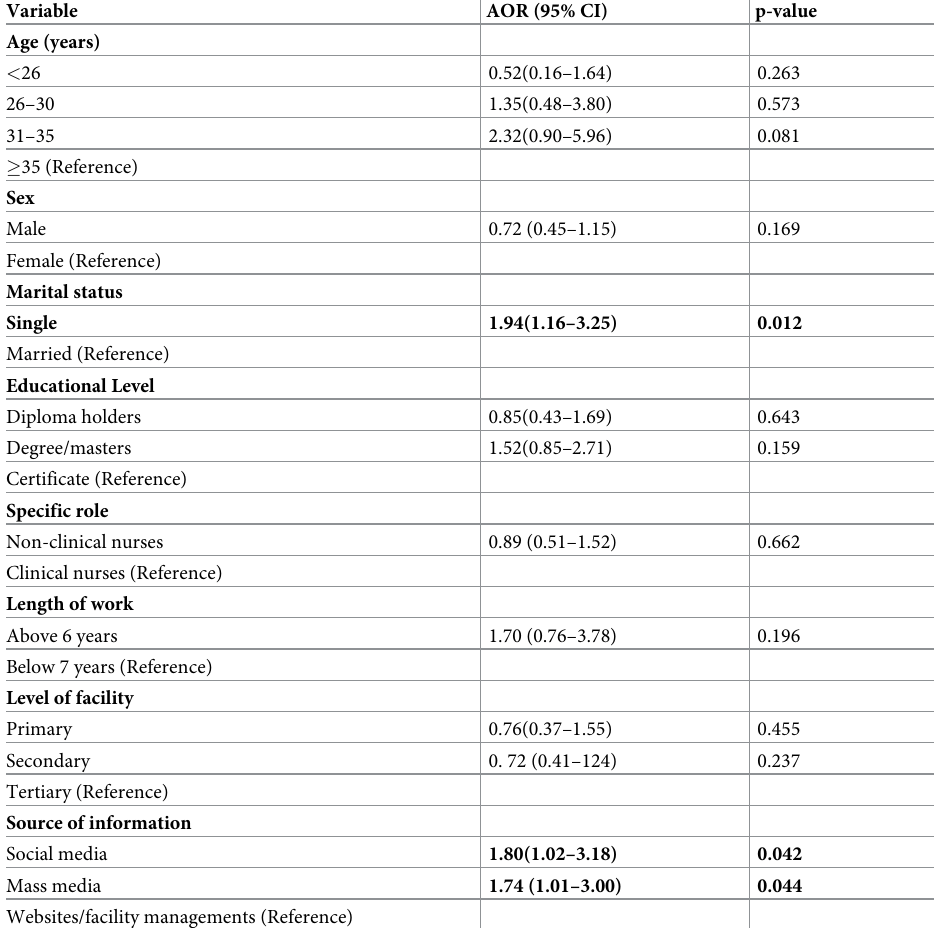
Table 2. Factors associated with nurses’ knowledge of COVID-19 safety protocols at health facilities in Tamale Metropolis, Ghana (n =